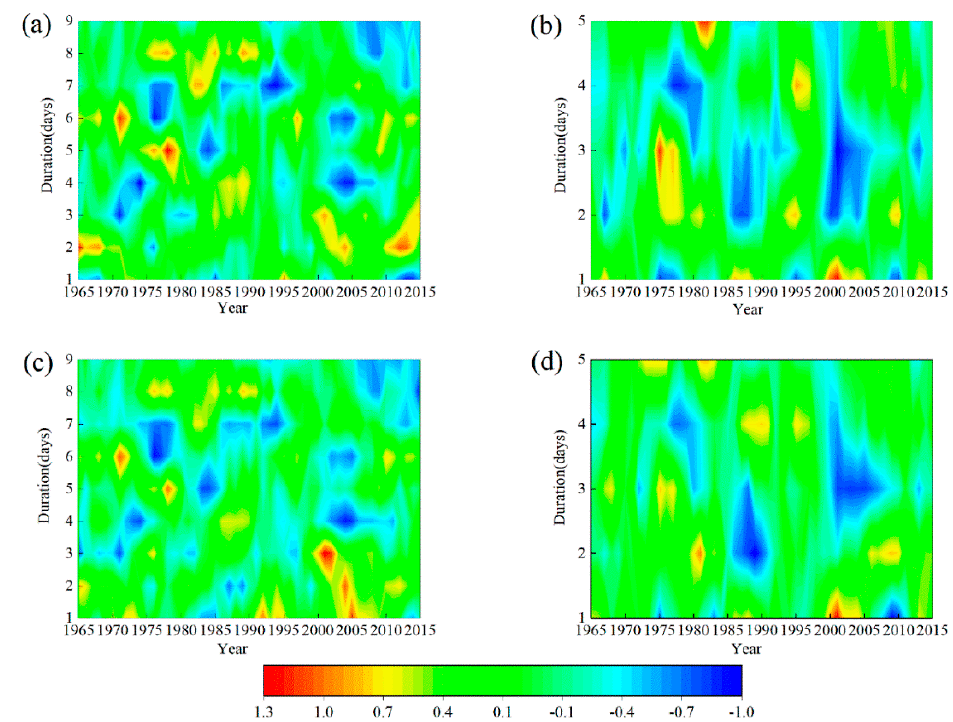
Figure 3. Temporal evolution of normalized occurrences ( a ) denotes the upper (UHRB) and ( b ) the middle (MHRB) reaches of the Heihe River Basin and fractional contribution ( c ) denotes UHRB, ( d ) denotes MHRB anomalies in different wet periods (WPs) in the UHRB and MHRB.